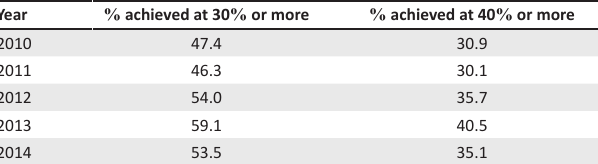
TABLE 1: National senior certificate mathematics achievement rates